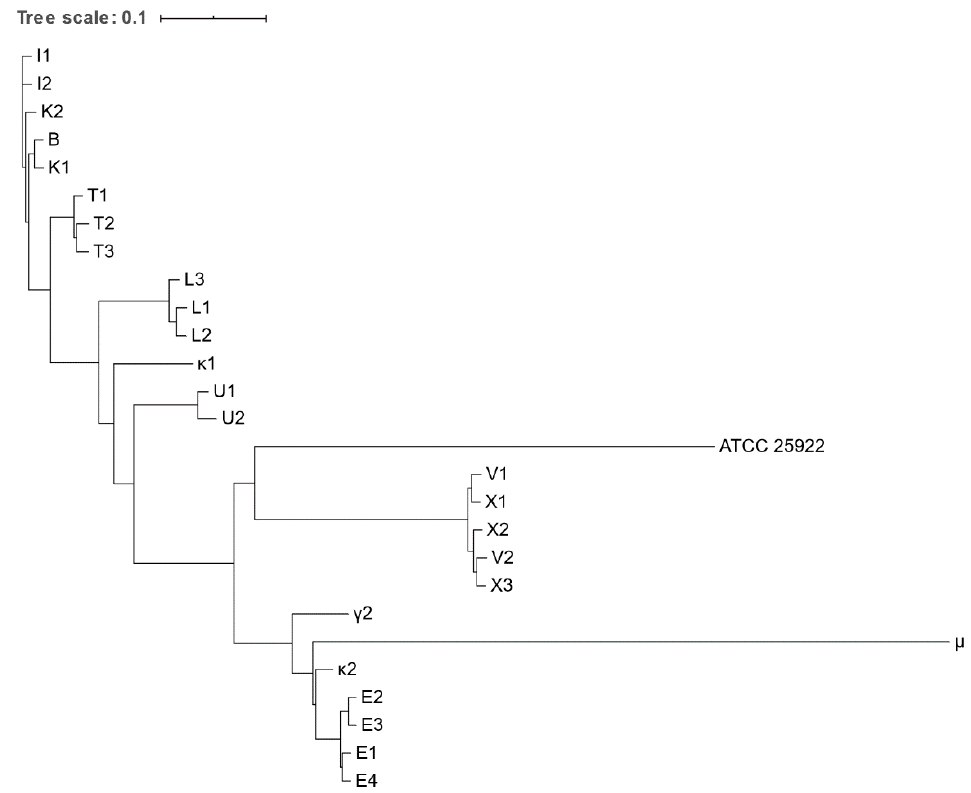
Figure 2. Phylogenetic tree based on the concatenated alignment of the high-quality SNPs alignment of Escherichia spp. isolates obtained from various zoo mammals. The scale-bar represents 1% differences in nucleotide sequences. All isolates were identified as E. coli , except for µ, which was identified as E. marmotae .